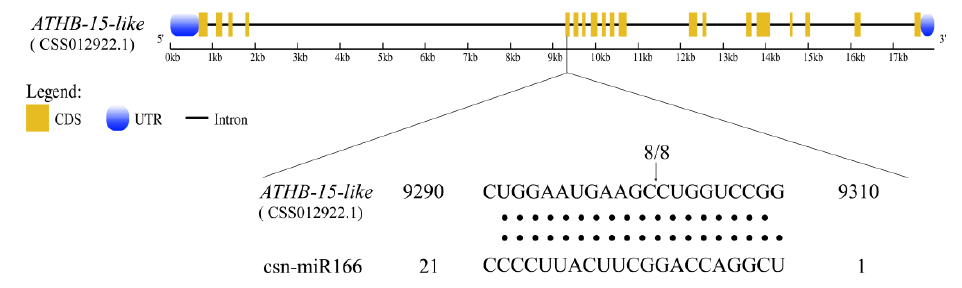
Figure 9. ATHB-15-like cleavage sites of csn-miR166s identified by 5 ′ RLM-RACE.